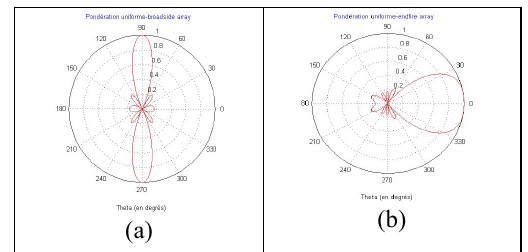
Fig. 2. Directivity diagrams for broadside array (a) and end fire array